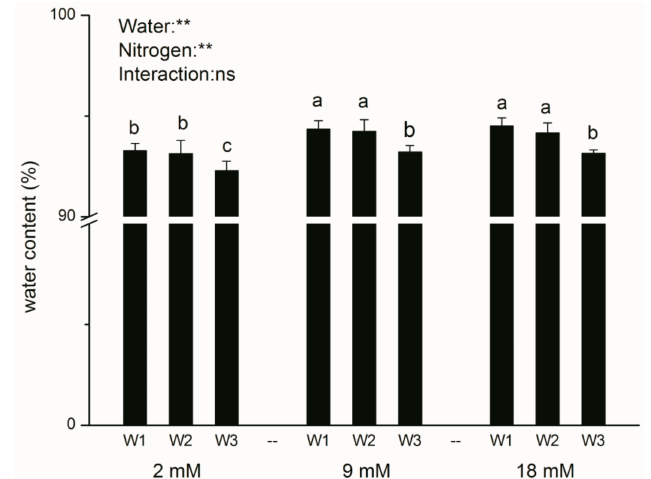
Figure 1. Plant water content of pakchoi at the end of the experiment. Bars with the different letters indicate significant difference ( p < 0.05). W1: 0 g · L − 1 polyethylene glycol (PEG) 6000, blank; W2: 60 g · L − 1 PEG 6000, mild drought stress; W3: 120 g · L − 1 PEG 6000, moderate drought. Error bars represent the standard deviation. p -values of the ANOVAs of drought, nitrogen supply, and their interaction are indicated. ns, not significant. ** p <